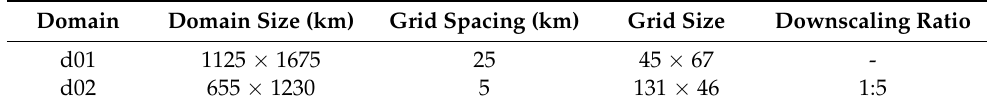
Table 1. Configurations of the two nested WRF model